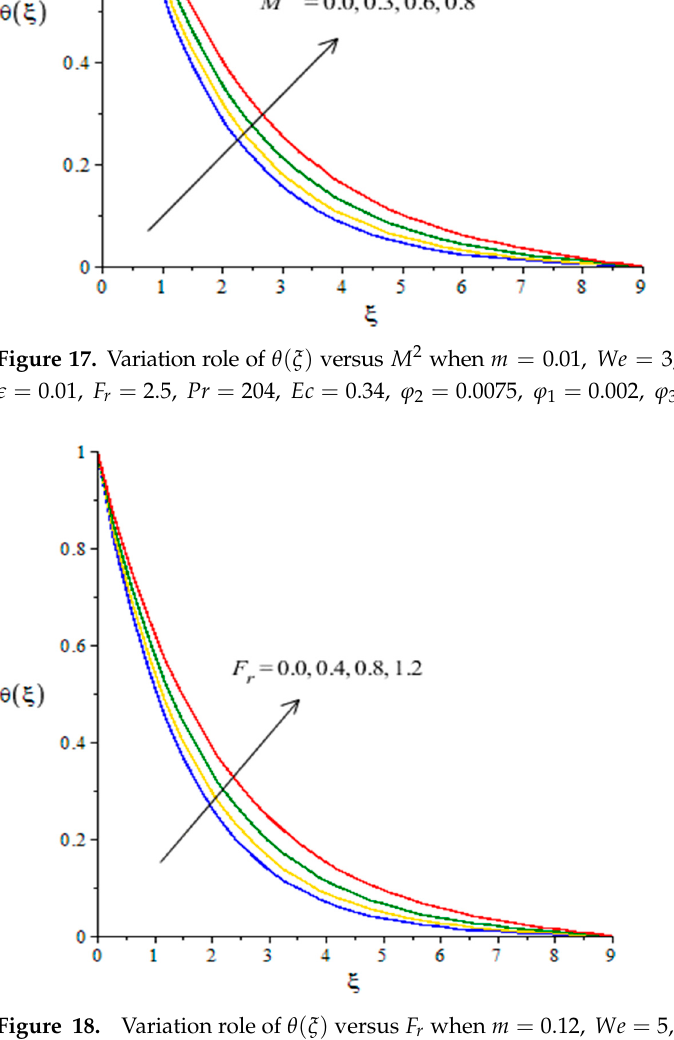
Figure 18. Variation role of θ ( ξ ) versus F r when m = 0.12, We = 5, Ω = 2.0, M 2 = 0.3, β e = 0.5, Figure 18. Variation role of 𝜃(𝜉) versus 𝐹 (cid:3045) when 𝑚 = 0.12,𝑊𝑒 = 5,Ω = 2.0,𝑀 (cid:2870) = 0.3,𝛽 (cid:3032) = 0.5,𝛽 (cid:3036) = 0.4,𝜖 = 0.1,𝑃𝑟 = 204,𝐸𝑐 = 0.34 = 5.0,𝜑 (cid:2870) = 0.0075,𝜑 (cid:2869) = 0.002,𝜑 (cid:2871) = 0.005. β i = 0.4, (cid:101) = 0.1, Pr = 204, Ec = 0.34 = 5.0, ϕ 2 = 0.0075, ϕ 1 = 0.002, ϕ 3 =